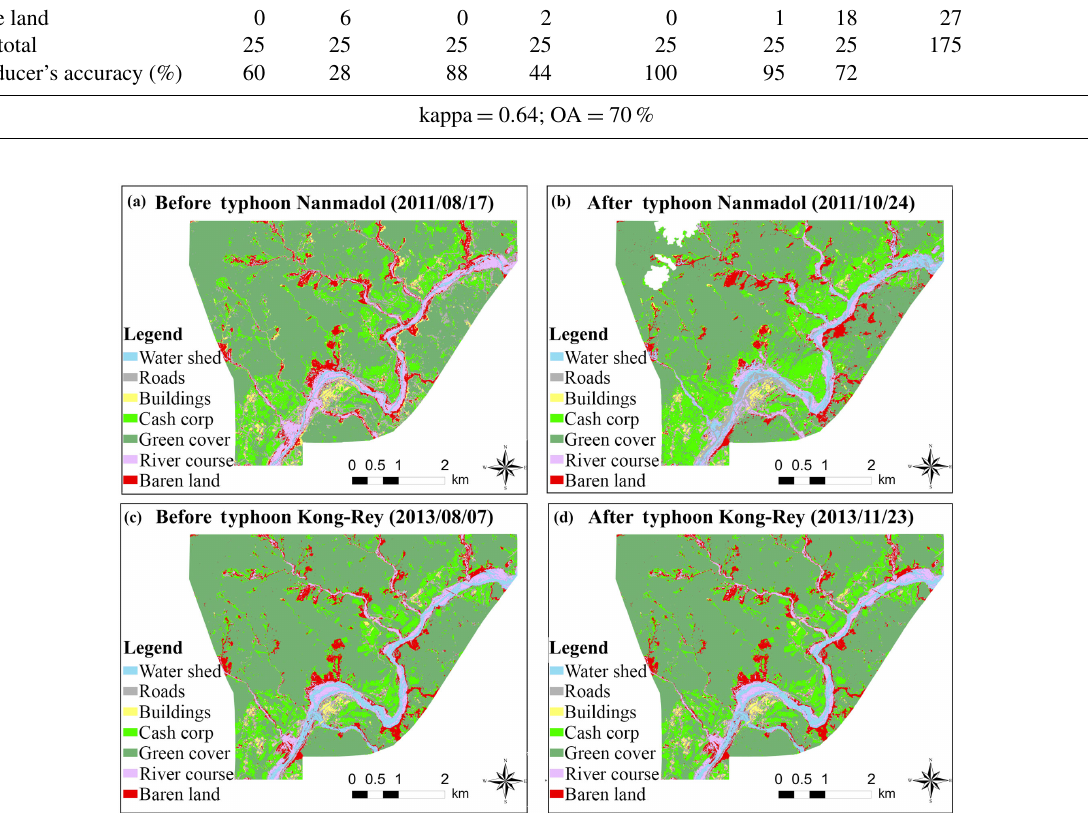
Figure 3. Interpretation and classification results of satellite images before (a, c) and after (b, d) Typhoon Nanmadol (a, b) and Typhoon Kong-rey (c, d)